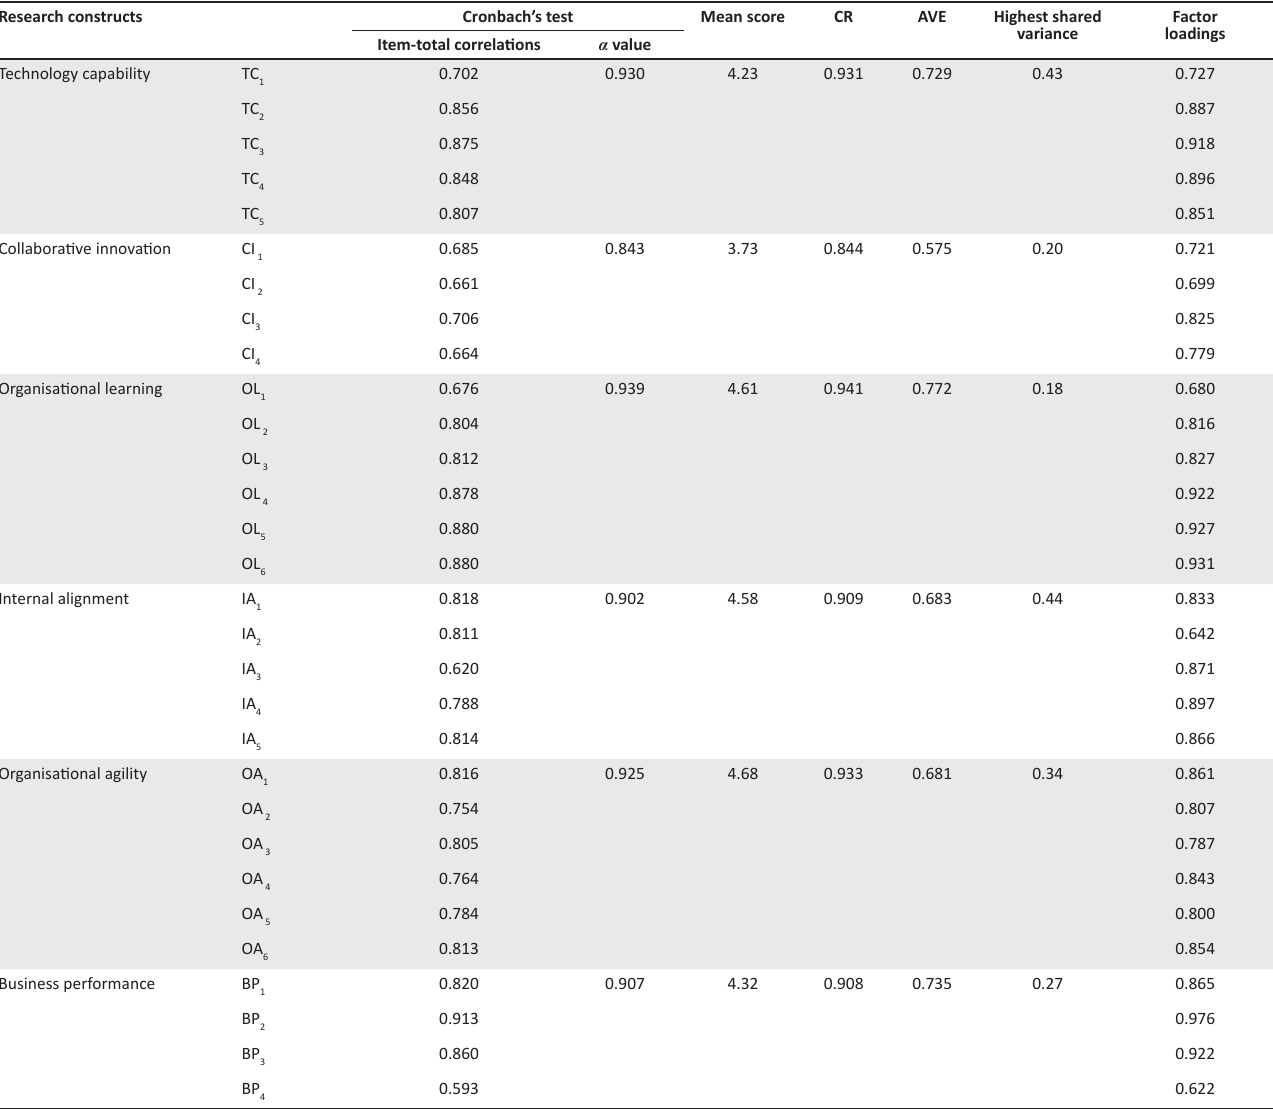
TABLE 2: Psychometric properties of the measurement scales. Research constructs